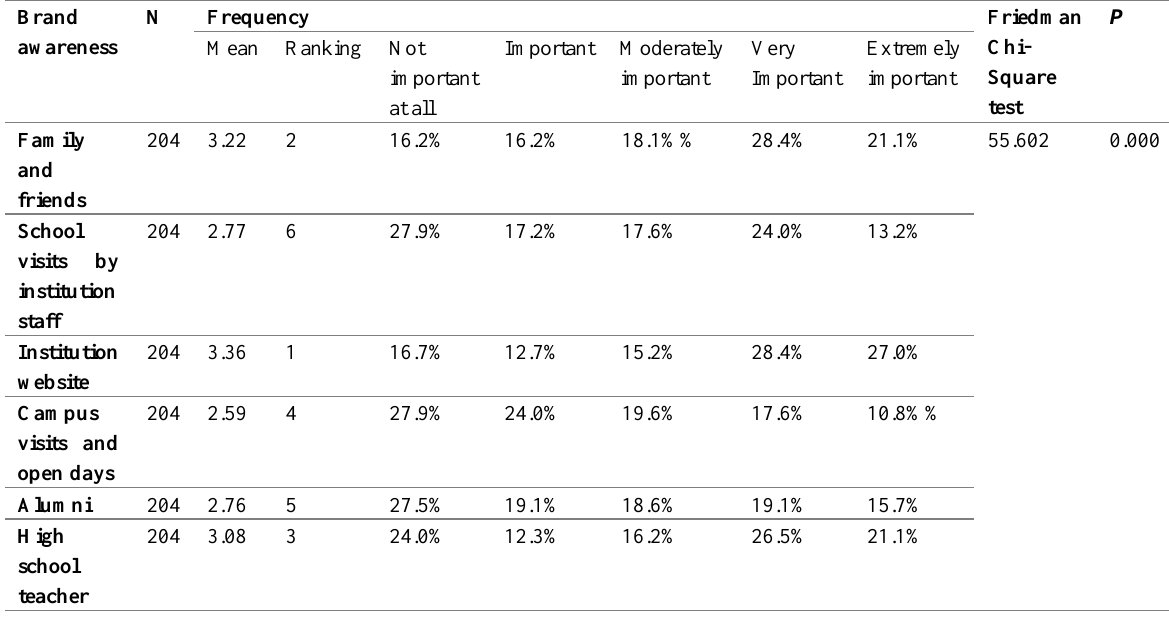
Table 7: MUT ranking of the important brand awareness